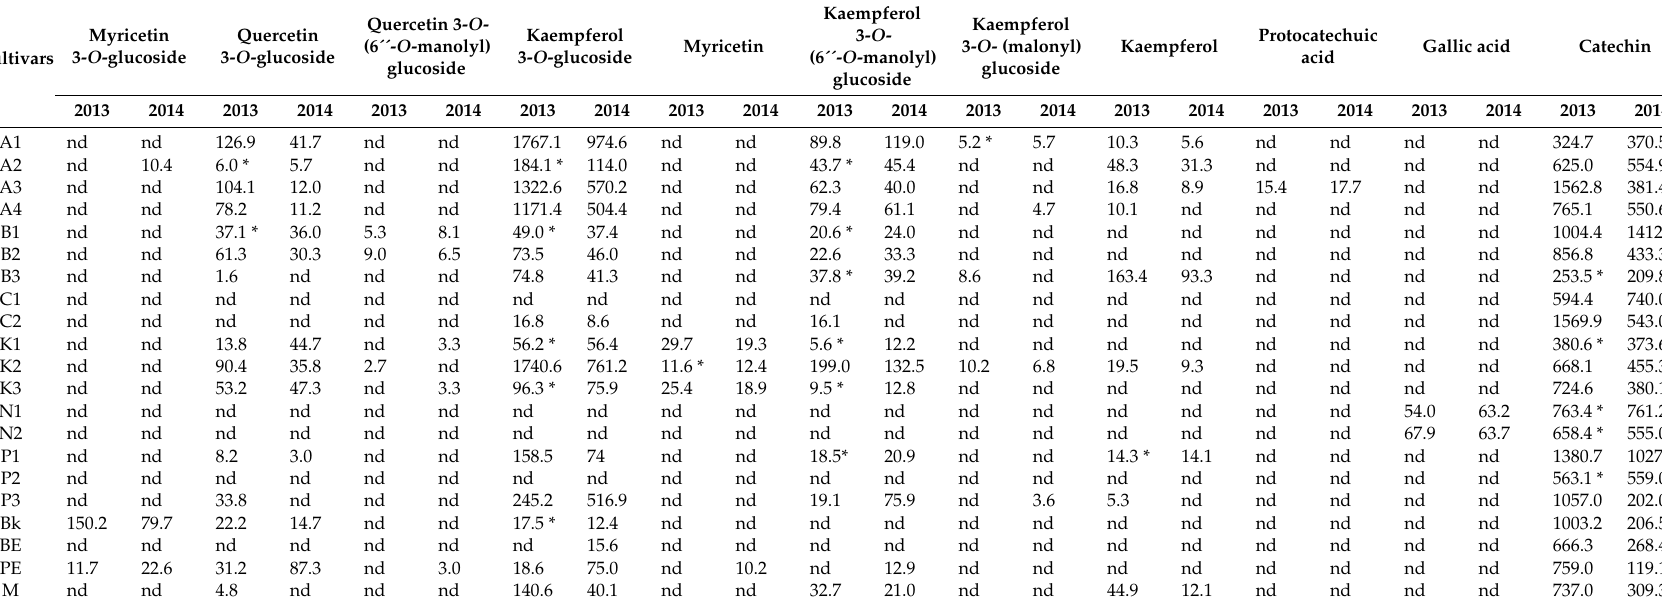
Table 2. Individual phenolic compounds of 10 common bean cultivars by HPLC-DAD for 2013 and 2014 harvest years, grouped according to their morphological characteristics, and expressed as µ g / g of dry weight sample. Cultivars: Arikara yellow (A1, A2, A3, A4), butter bean (B1, B2, B3), cranberry (C1, C2), red kidney